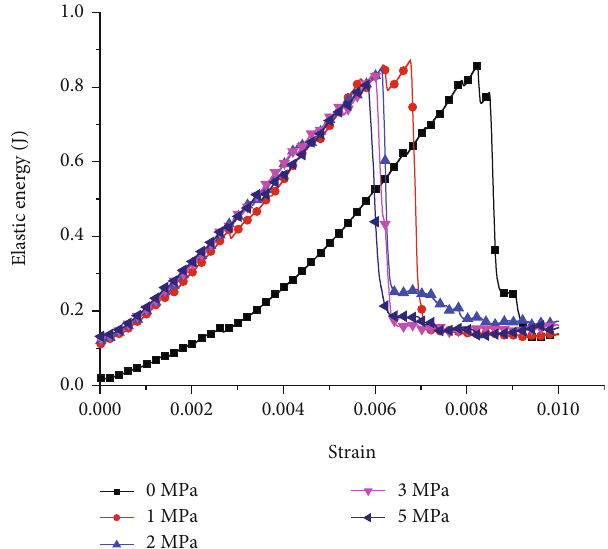
Figure 12: Changes of the elastic energy during deformation and failure under di ff erent gas